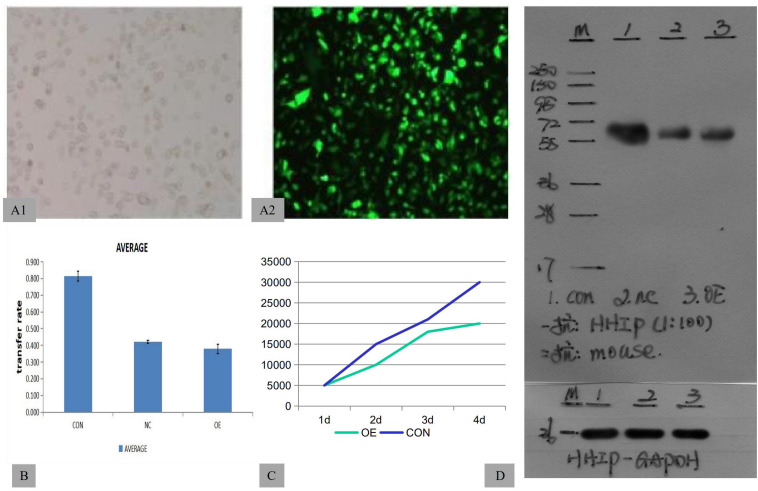
HHIP overexpression was induced by lentivirus-delivered HHIP and inhibited the proliferation of AGS cells. (A1–2) The efficiency of lentiviral transduction was monitored by fluorescence microscopy. (B) The results of transwell assays showed that the invasive rate of OE group was lowest among three groups (CON>NC>OE). (C) MTT assays showed that the cell number of OE group is less than CON group. (D) The protein levels of HHIP were assessed by western blotting with an anti-Flag antibody. The size of the band showing the target fusion protein was near 58 kD. M: marker; 1: LV-CON-3FLAG-GFP; 2: LV-NC-3FLAG-GFP; and 3: LV-HHIP-OE-GFP. (NC: negative control, OE; overexpression).